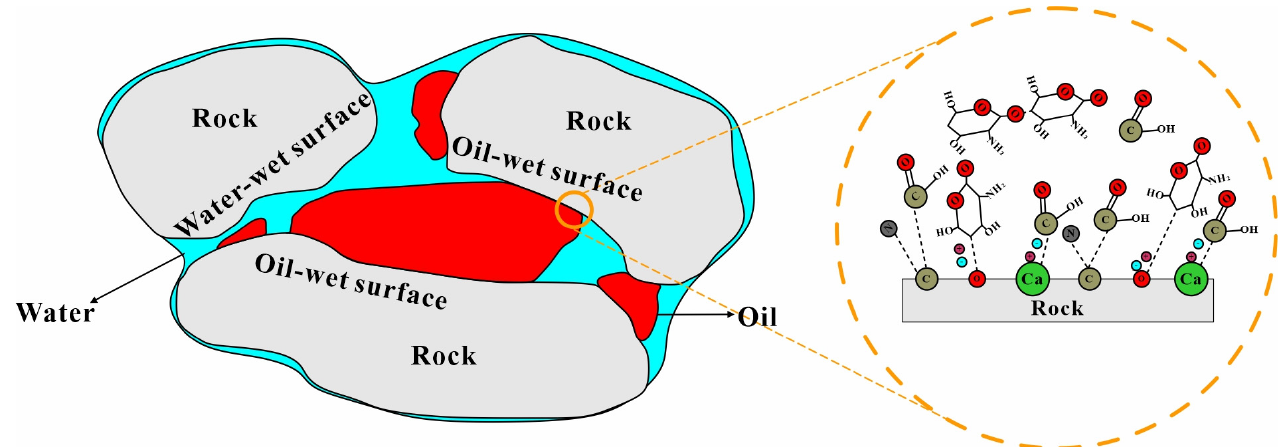
Figure 11. Adsorption of oil on the oil-wet surface of the rock.